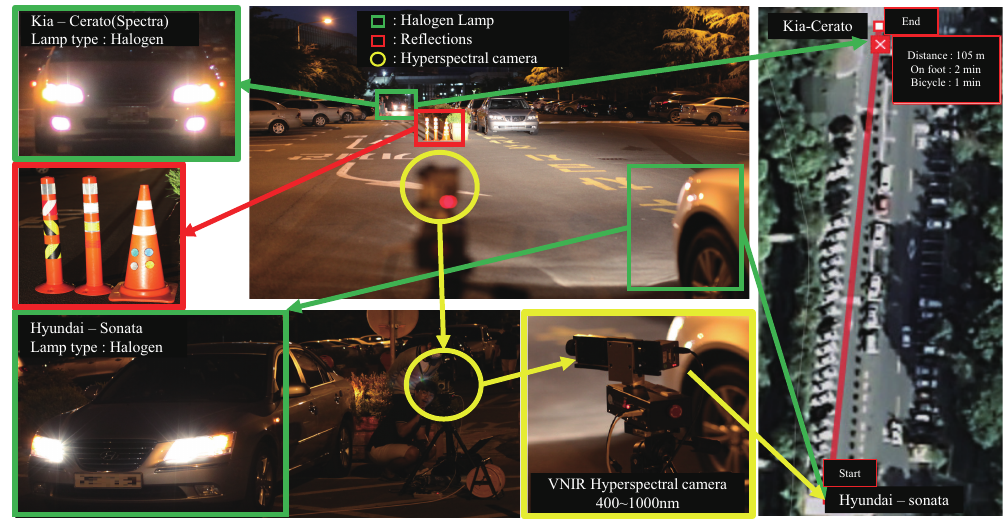
Figure 12. Introduction to the experimental environment.